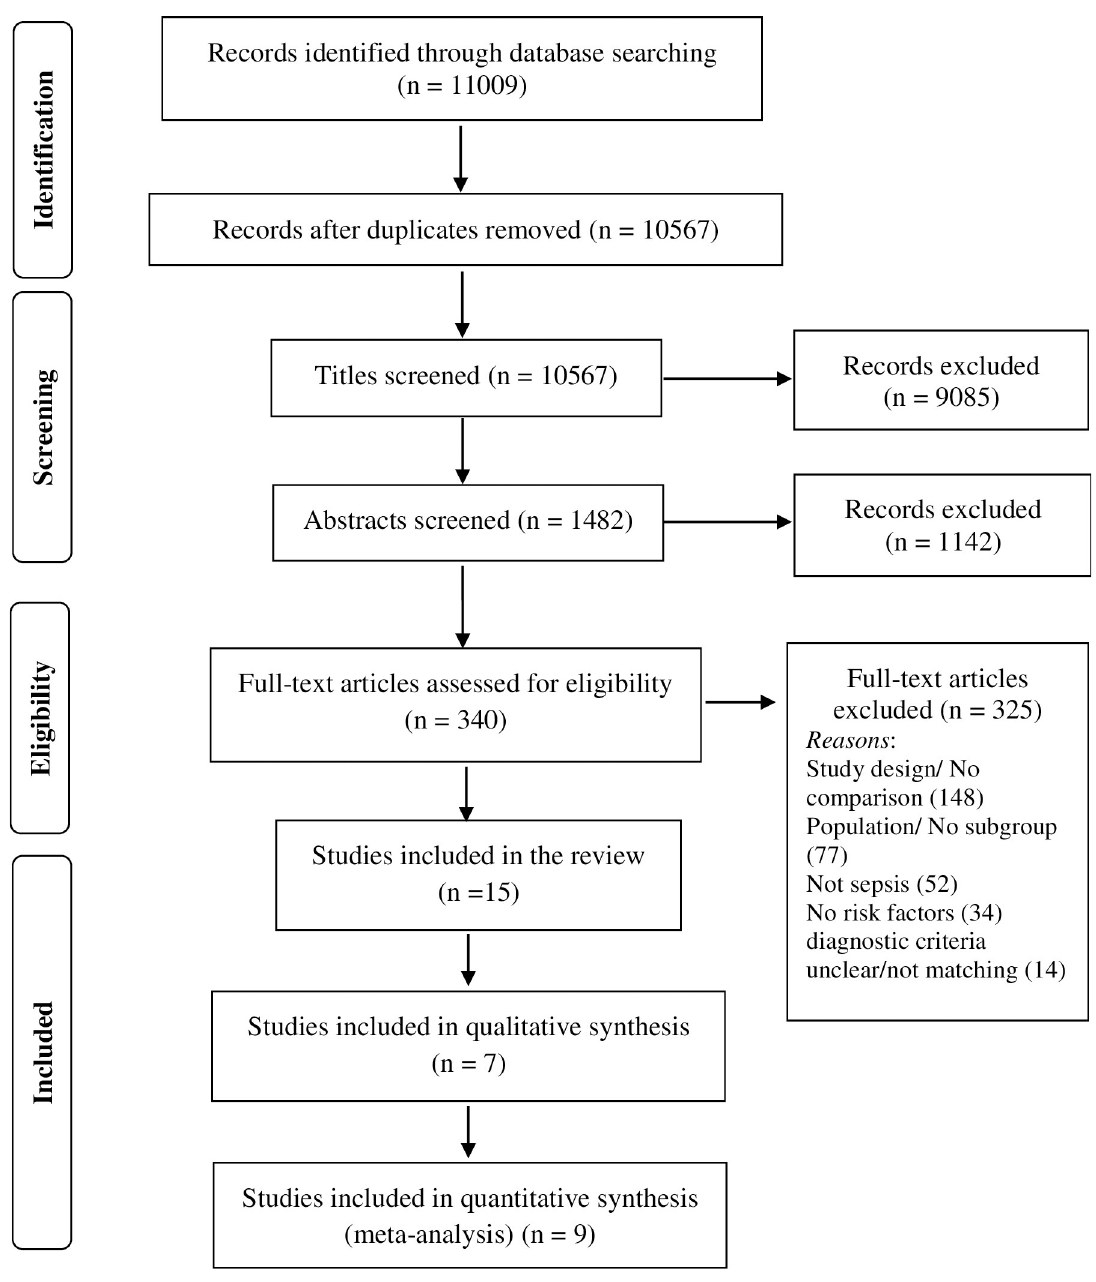
Fig 1. A PRISMA chart outlining the study selection results in our